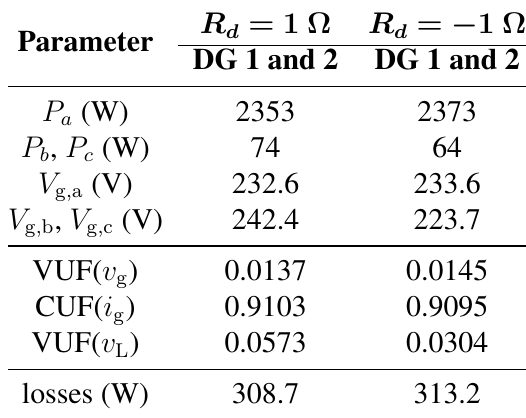
Table 7. Islanded microgrid with two DG units: RU versus the CW variant ( R R = 0 Ω ). v